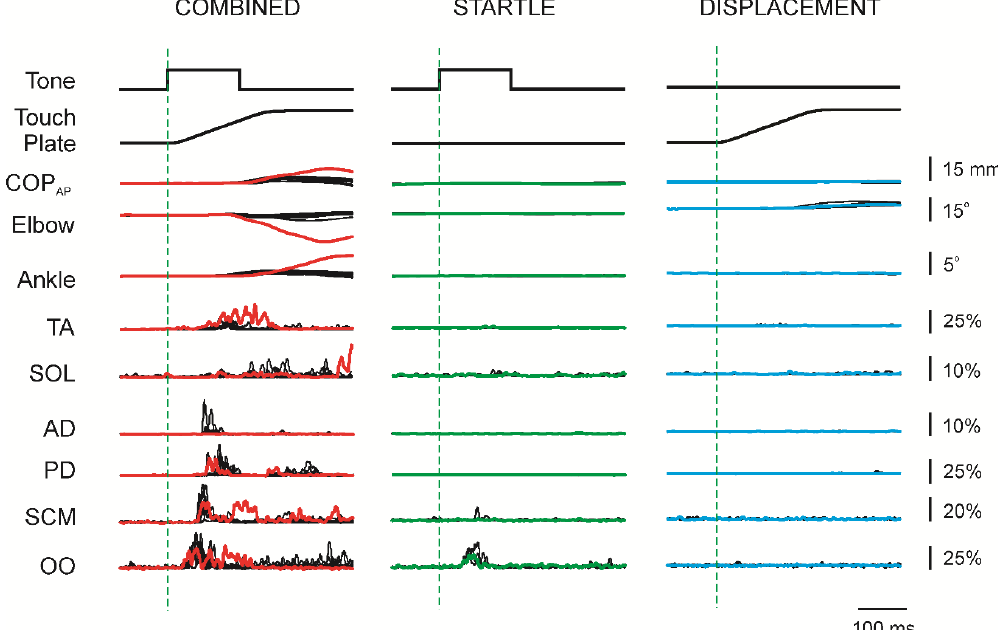
Figure 4. Sample data traces from a single participant who received the COMBINED stimuli initially. Each cluster of traces represents the complete series of trials for that stimulus mode, with the coloured traces representing the first trial for that stimulus mode (Red, COMBINED; Green, STARTLE; Blue, DISPLACEMENT). The thin black lines of each cluster represent the subsequent trials. The vertical dashed line is aligned to the onset of the stimuli. Positive deflections in the COP AP traces represent forward, elbow traces represent extension, and ankle traces represent plantarflexion. COP AP , center of pressure anterior–posterior; TA, tibialis anterior; SOL, soleus; AD, anterior deltoid; PD, posterior deltoid; SCM, sternocleidomastoid; OO, orbicularis oculi.